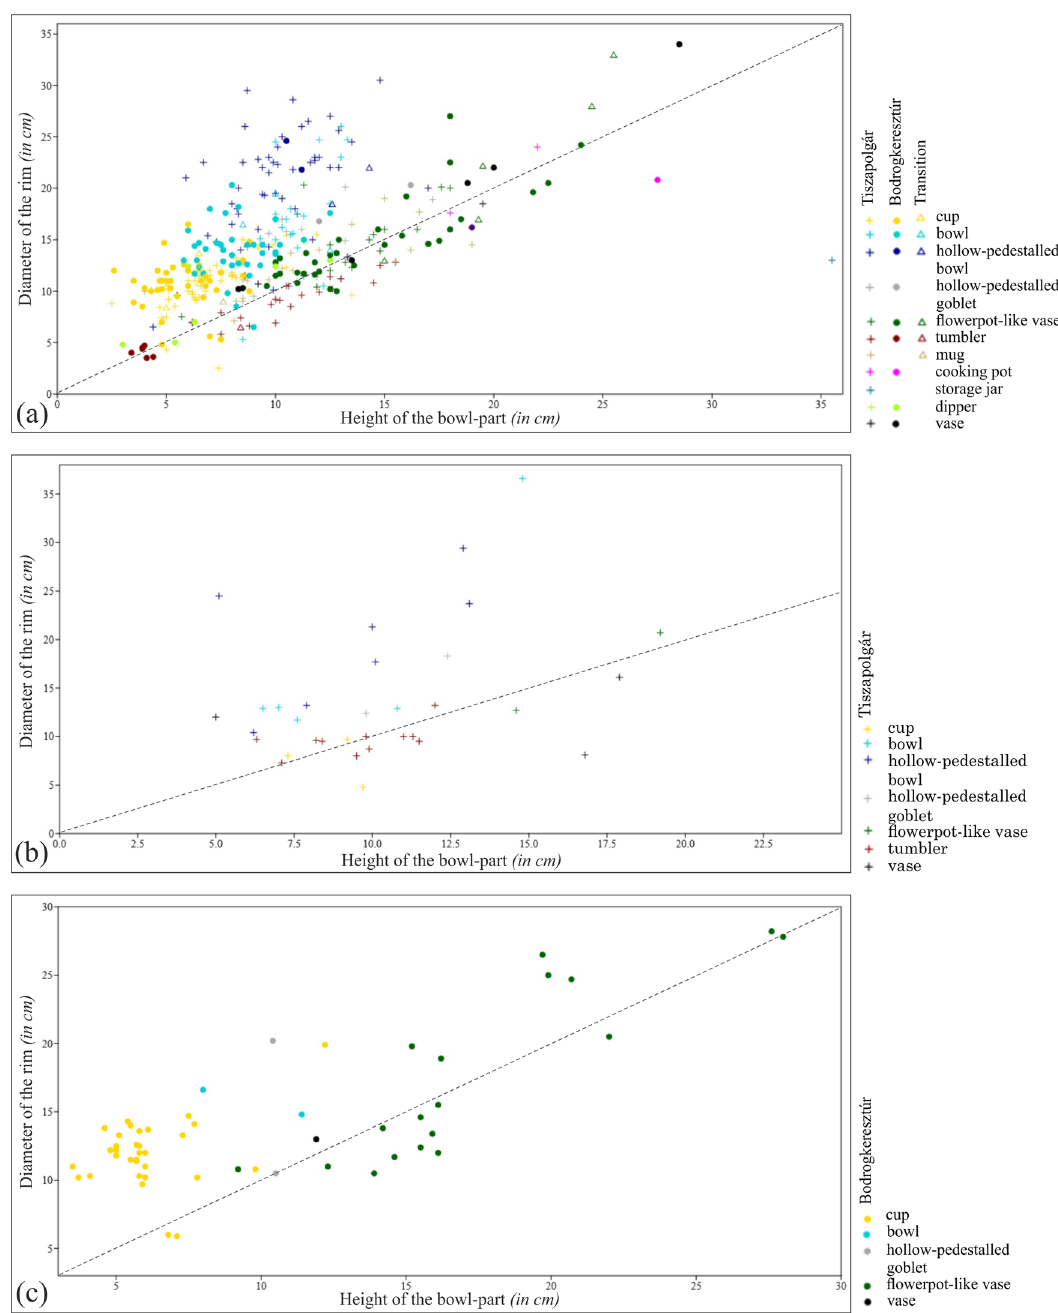
Figure 5: Scatter plot of neckless vessels at: ( a ) Tiszapolgár - Basatanya; ( b ) Tiszavalk - Kenderföld; and ( c ) Polgár - Nagy - Kasziba and Tiszabábolna - Szilpuszta ( the legends contain the traditional typological terms to visualise their metrical distribution ) pieces ( almost entirely represented by form A1 ) was the most dominant vessel category: rim diameter < 18 cm or ≤ 8 cm; bowl height < 14 cm, depending on the site, ( 2 ) wide, shallow neckless vessels occurring with or without pedestal ( classi fi ed mainly as form A2, but some pieces resembling form A1 also belong here ) : rim diameter ≥ 18 cm; bowl height < 14 cm, and ( 3 ) large, 1/1 ratio neckless vessels ( represented by form B1 and form A1 ) : bowl height < 14 cm or < 8 cm, depending on the site, but their rim diameter and height increase equally to almost 1:1. Metric examinations focusing on vessels with neck parts were able to distinguish two groups ( Figure 2 ) : ( 1 ) regular - sized ceramics with necks ( the vast majority of which